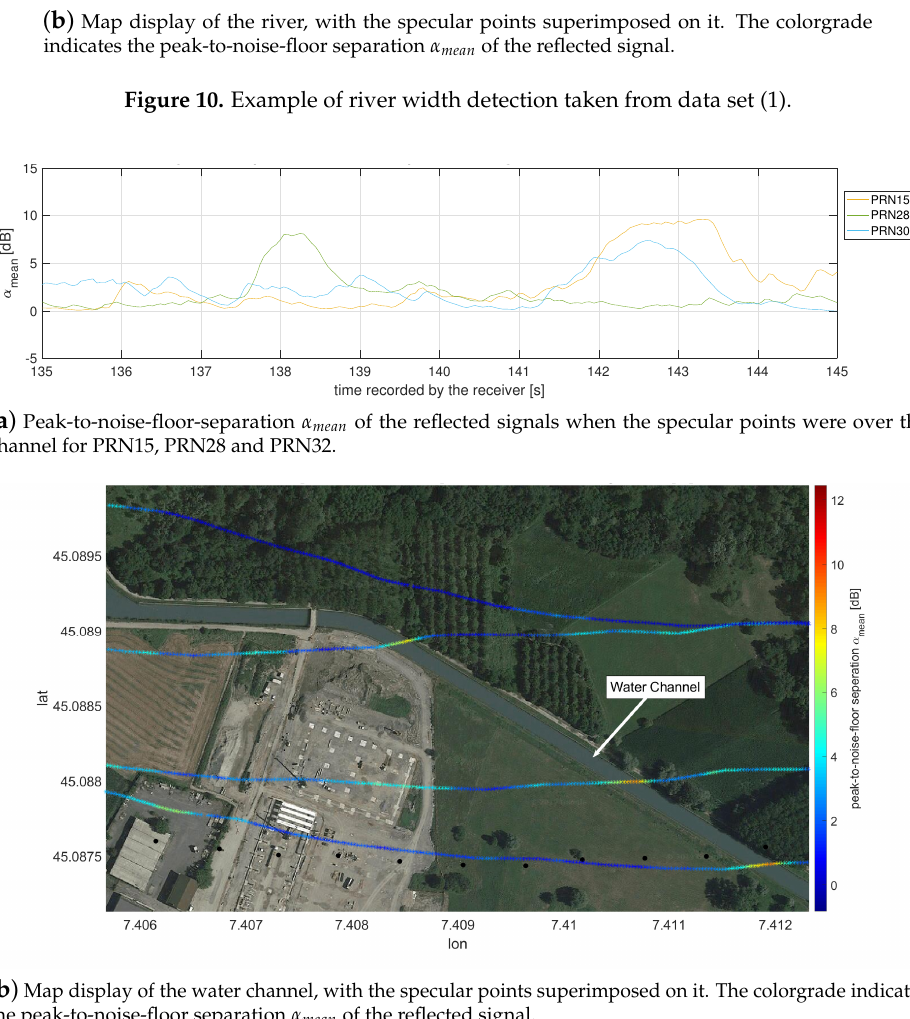
Figure 11. Example of water channel width detection taken from data set